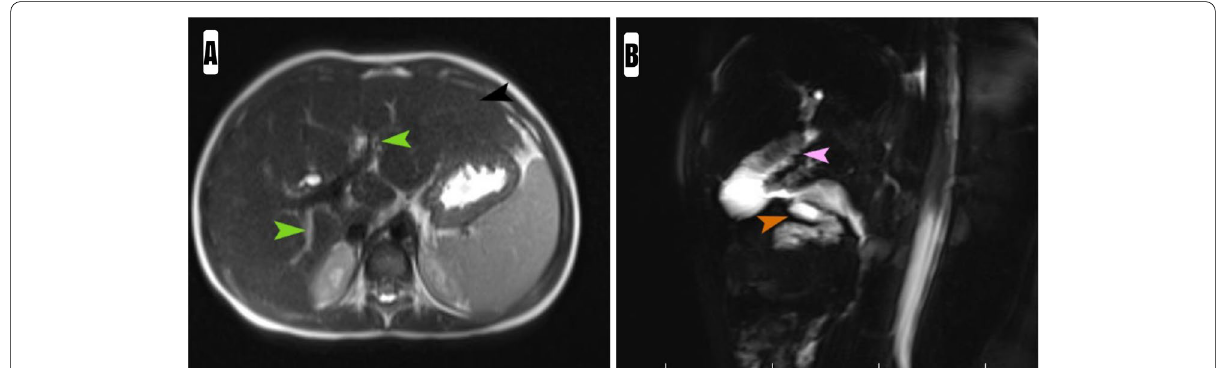
Fig. 5 A and B : Postoperative MRCP showing ( A ) enlarged liver parenchyma with cirrhotic changes seen as irregular borders (black arrowhead). Bilobar central and peripheral intrahepatic biliary radicles appear normal (green arrowheads). An empty GB fossa seen. No T2W hypointense filling defect is seen in the lumen. ( B ) Roux-en-Y hepaticojejunostomy reconstruction in situ with a patent Roux (pink arrowhead) and Y (brown arrowhead)